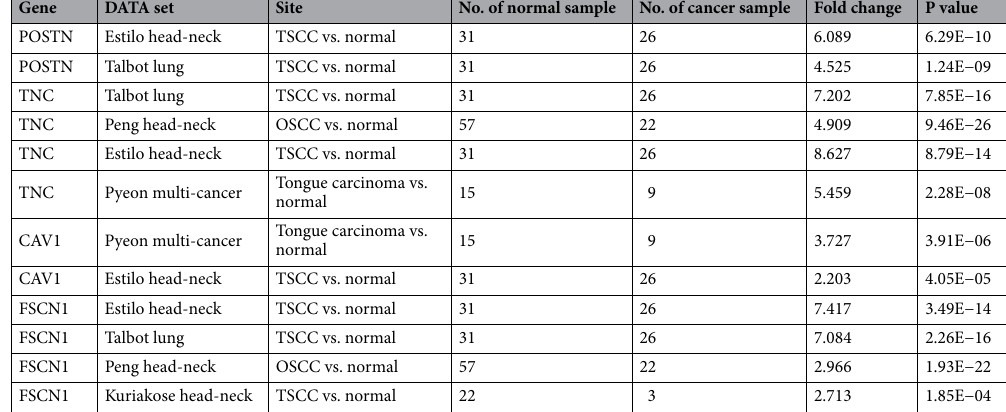
Table 5. Detailed panel of candidate OSCC genes. The mRNA expression status (OSCC/TSCC vs normal) of a gene as reported in the Oncomine database).